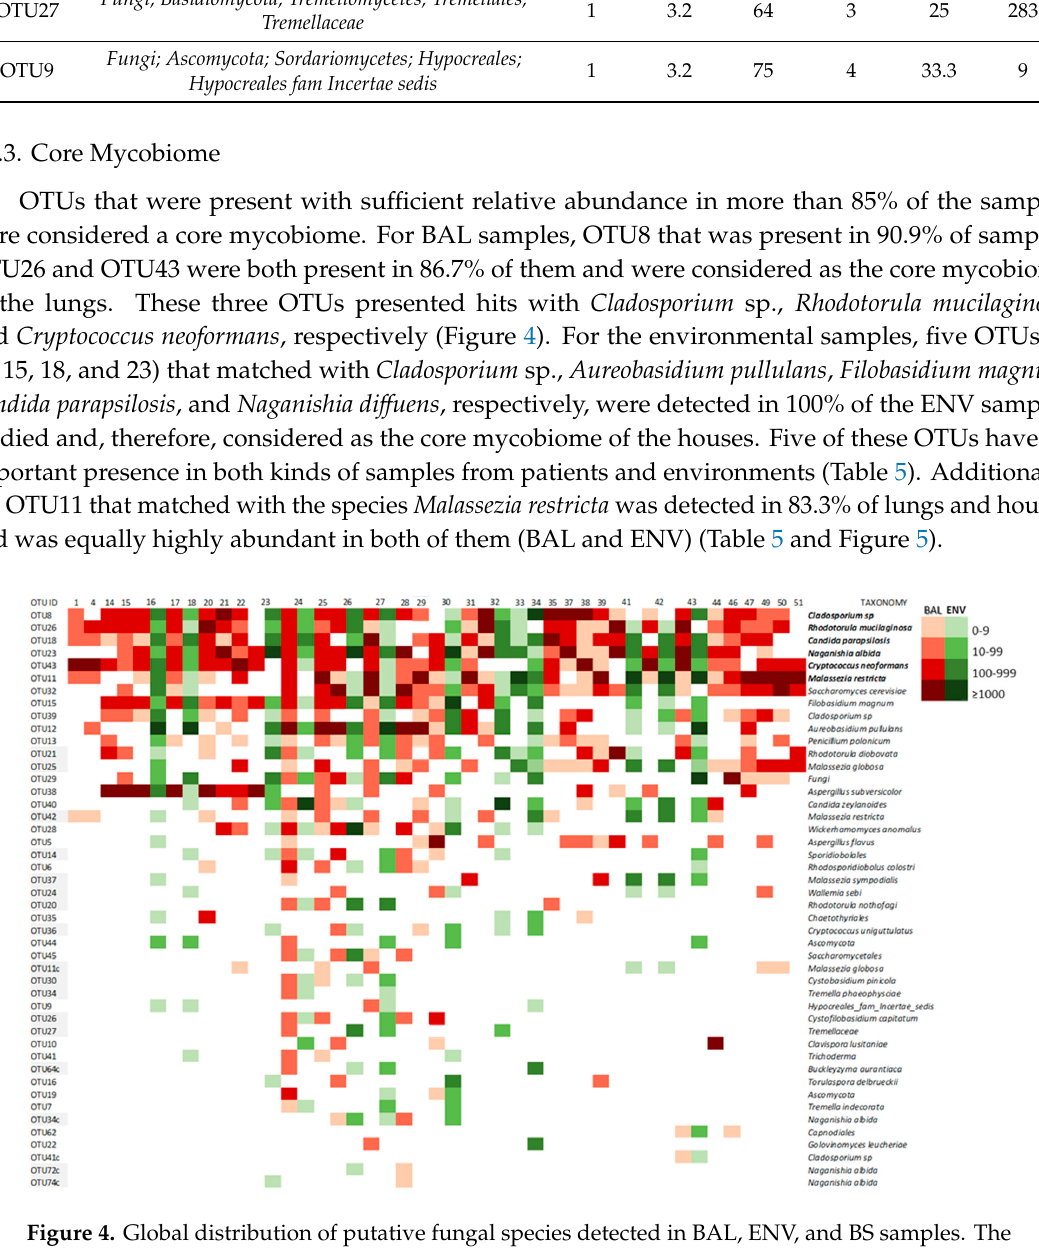
Figure 4. Global distribution of putative fungal species detected in BAL, ENV, and BS samples.